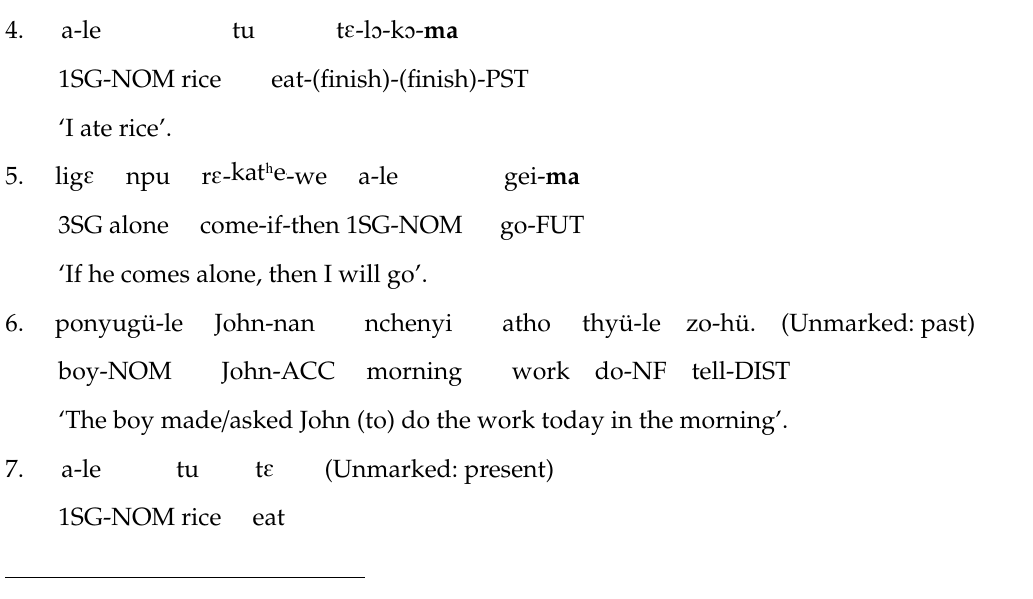
book bring-finish 3FSG